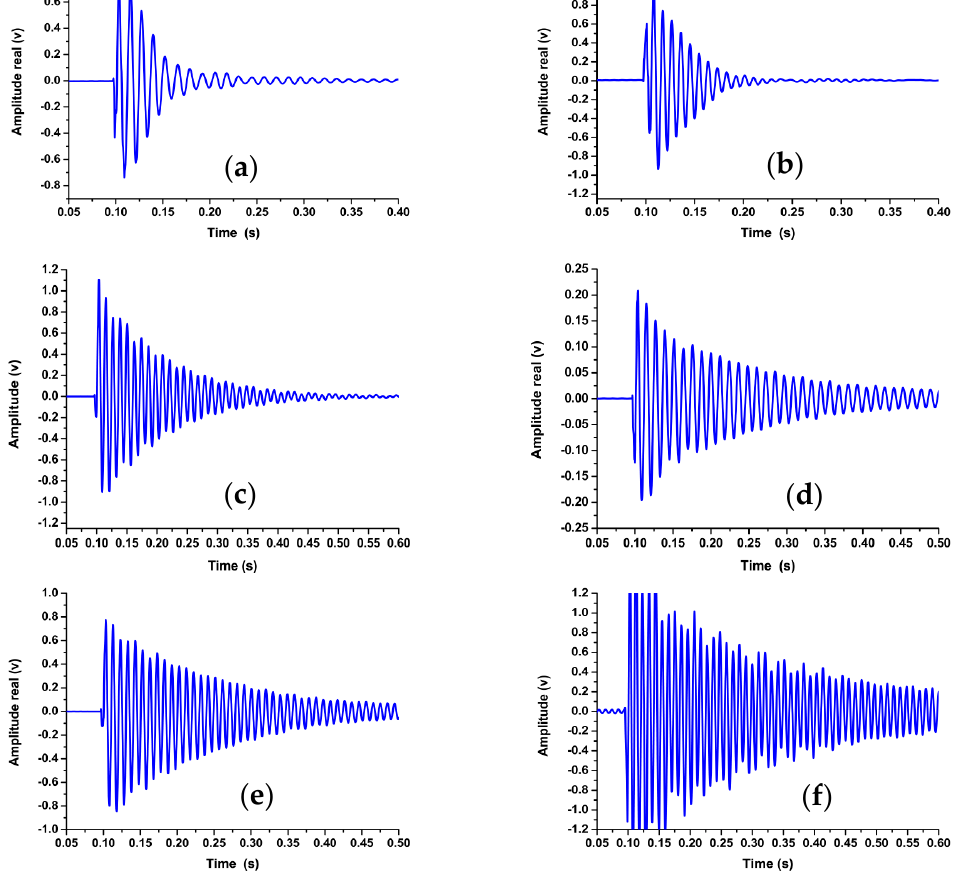
Figure 4. Transient response acquired from the free vibration impact test at ( a ) 600 rpm with a welding rate of 16 mm/min, ( b ) 1500 rpm with a welding rate of 52 mm/min, ( c ) 1500 rpm with a welding rate of 110 mm/min, ( d ) 600 rpm with a welding rate of 110 mm/min, ( e ) 1200 rpm with a welding rate of 32 mm/min, and ( f ) 1000 rpm with a welding rate of 110 mm/min.